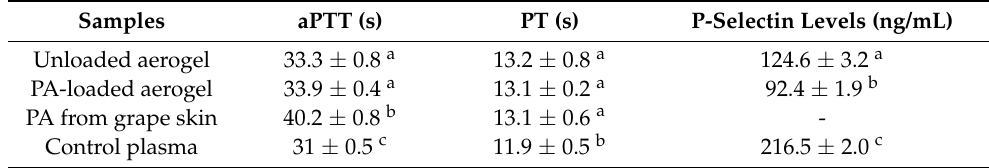
Table 4. aPTT and PT measurements for PA-rich extracts, aerogels and control plasma.